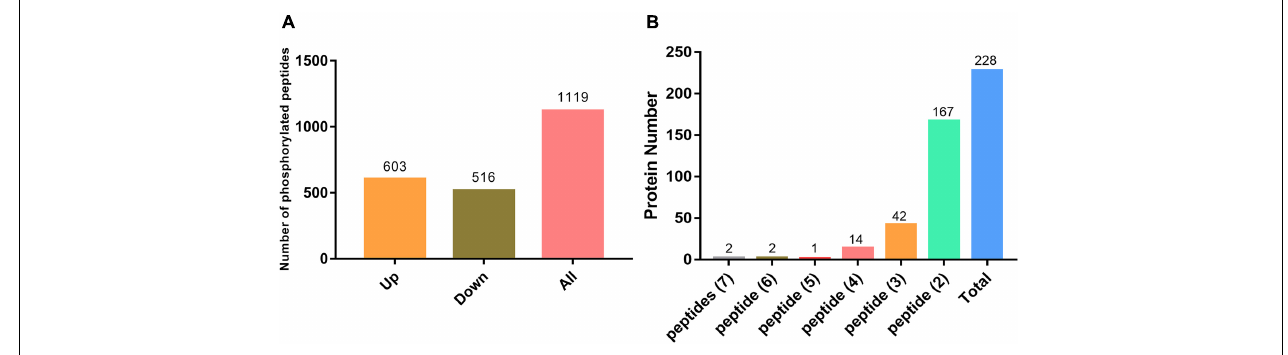
FIGURE 3 | Phosphoproteomic analysis. (A) Significantly changed phosphorylated peptides in systemic leaves of Psm ES4326-inoculated plants. (B) Phosphoproteins containing three or more significantly changed phosphorylated peptides in systemic leaves of Psm ES4326-inoculated